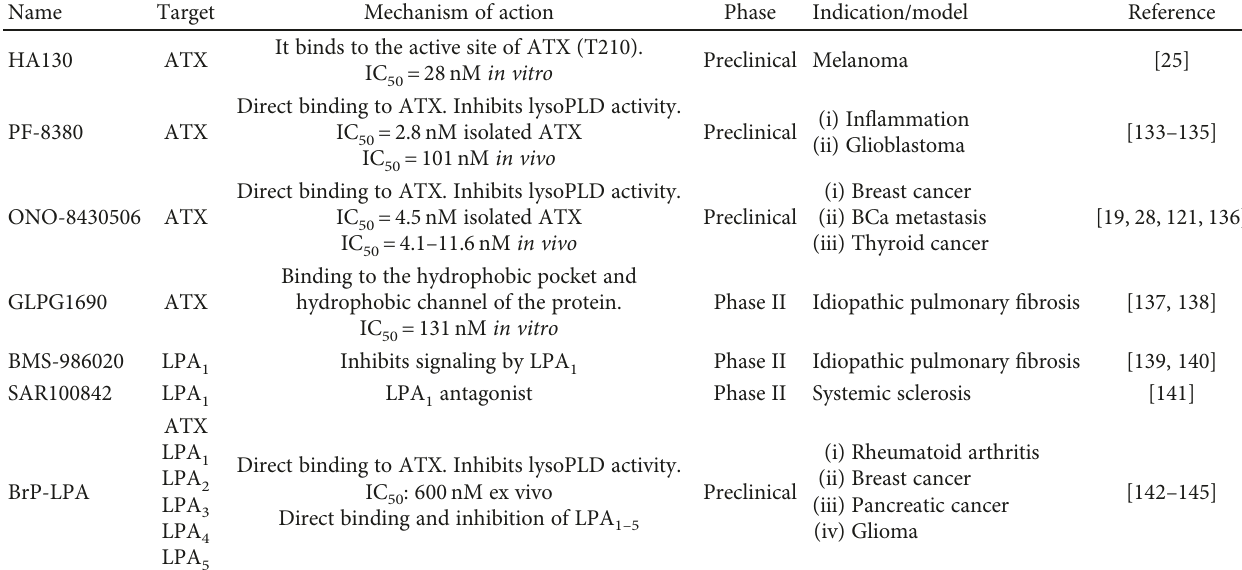
Table 1: Targeting the ATX-LPA axis in cancer and in fl